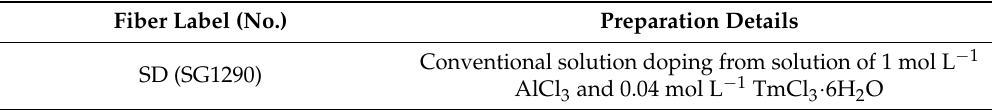
Table 2. Basic properties of the selected optical fiber used for the evaluation of the cross-relaxation coefficients of Tm-ions as well as for the fabrication of compact all-fiber ring